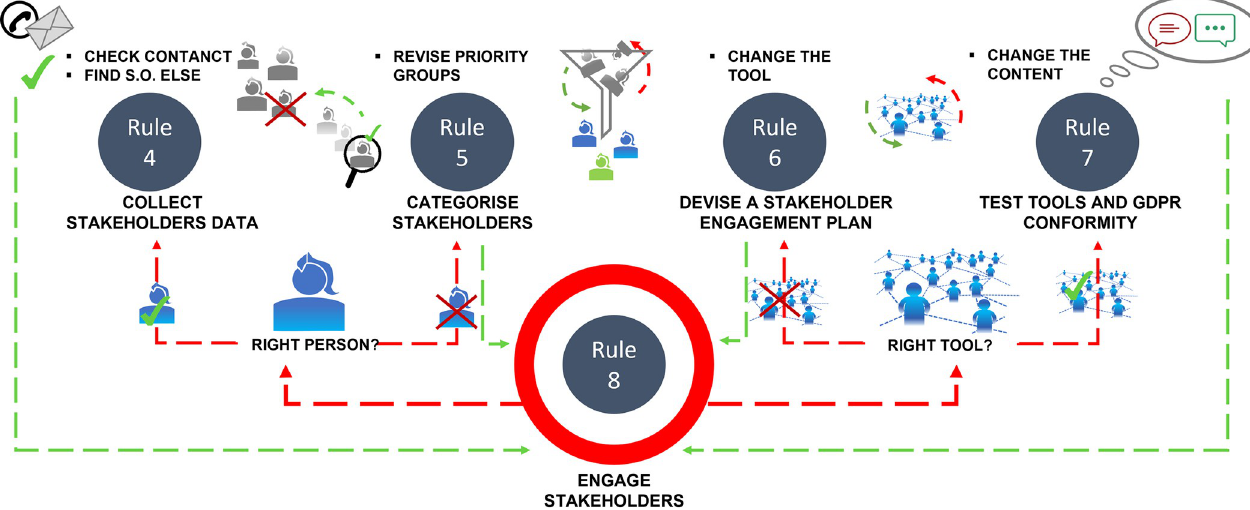
Fig 2. How to revise the stakeholder engagement strategy. If the stakeholder engagement is not successful, it may be necessary to revisit previous rules and, especially, to check contacts, replace unresponsive stakeholders, and change the content and/or the communication flow. The scheme demonstrates the workflow for